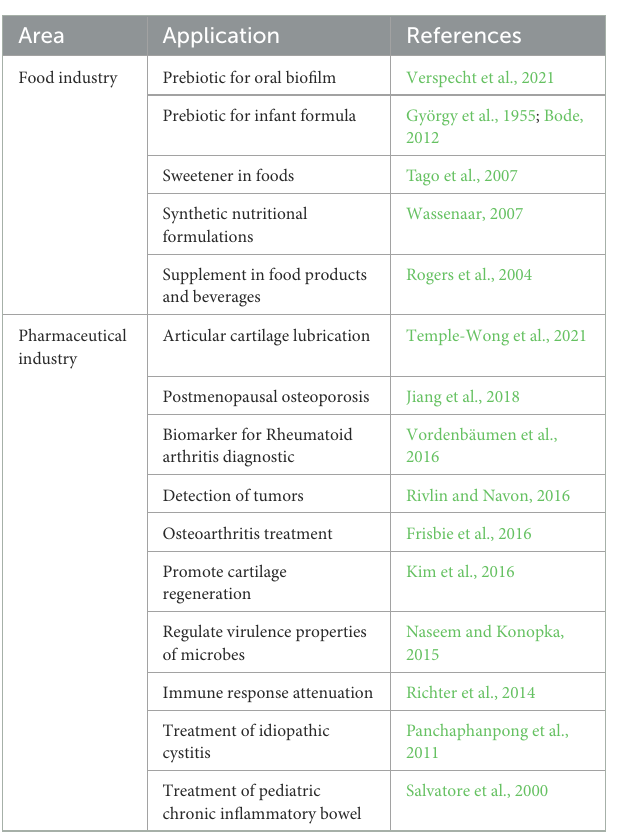
TABLE 3 N-Acetyl-glucosamine